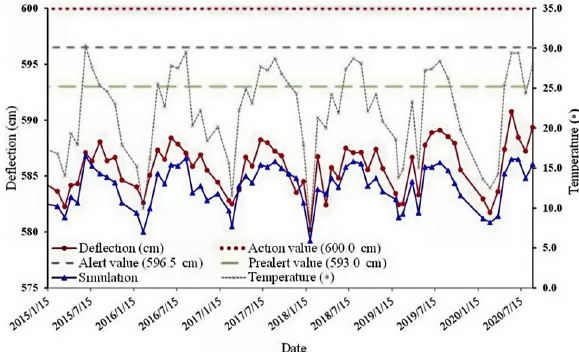
Figure 16. Comparison between the simulation results and observation of main cable central